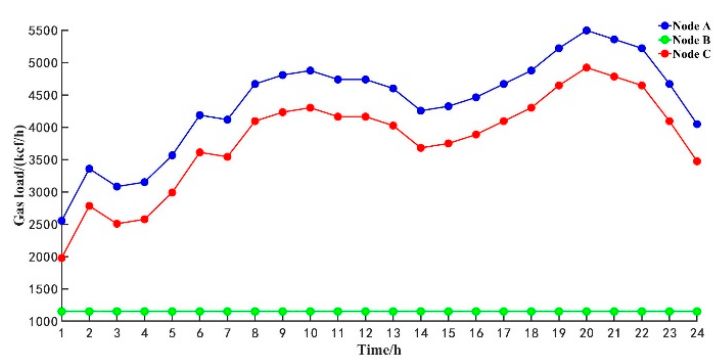
Figure A2. Typical daily natural gas load for planning.